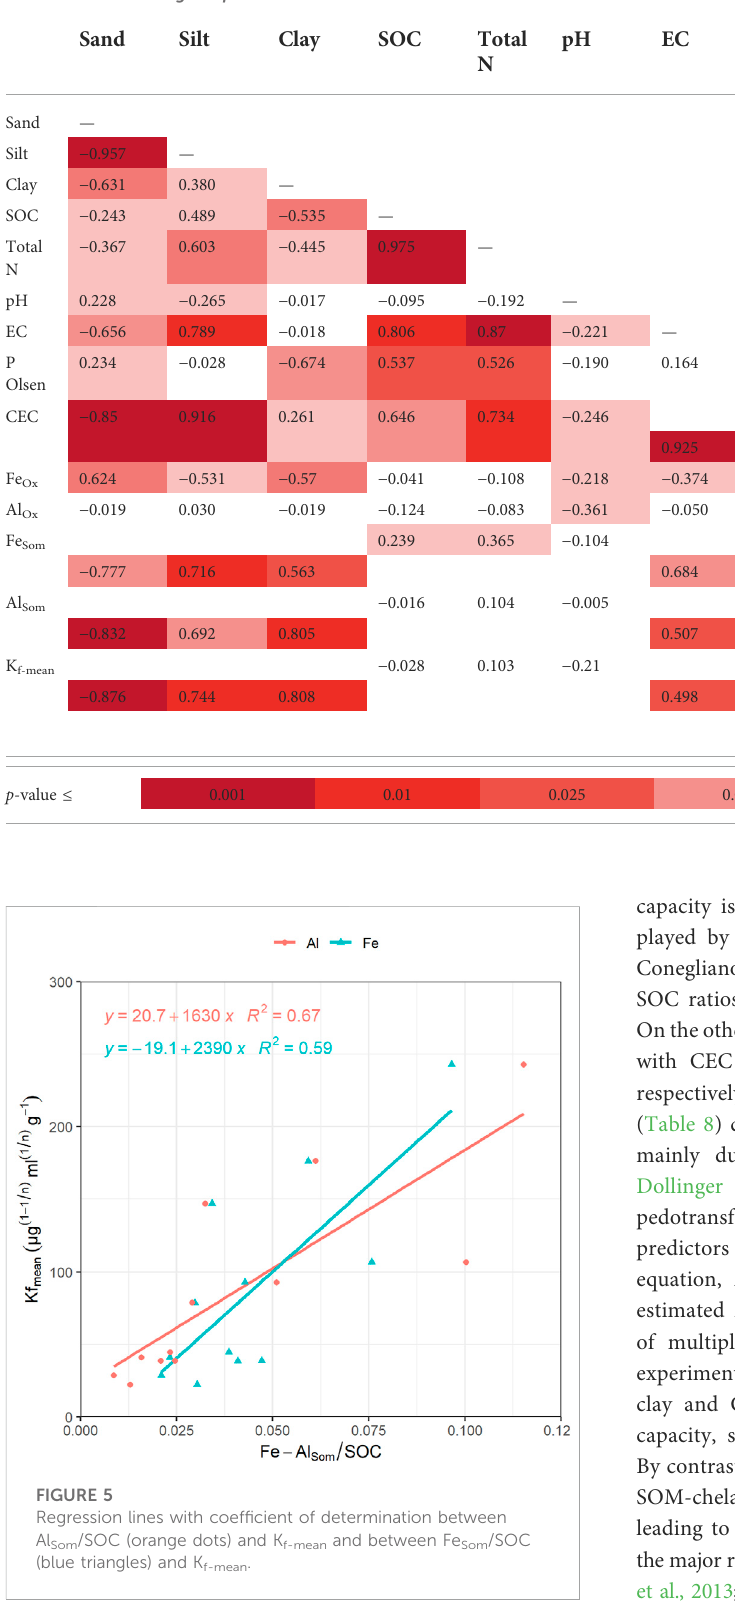
TABLE 8 Pearson correlation coef fi cient matrix between sorption coef fi cients and soil properties in the four monitoring stations (N = 13). Different colors indicate a range of p -values.